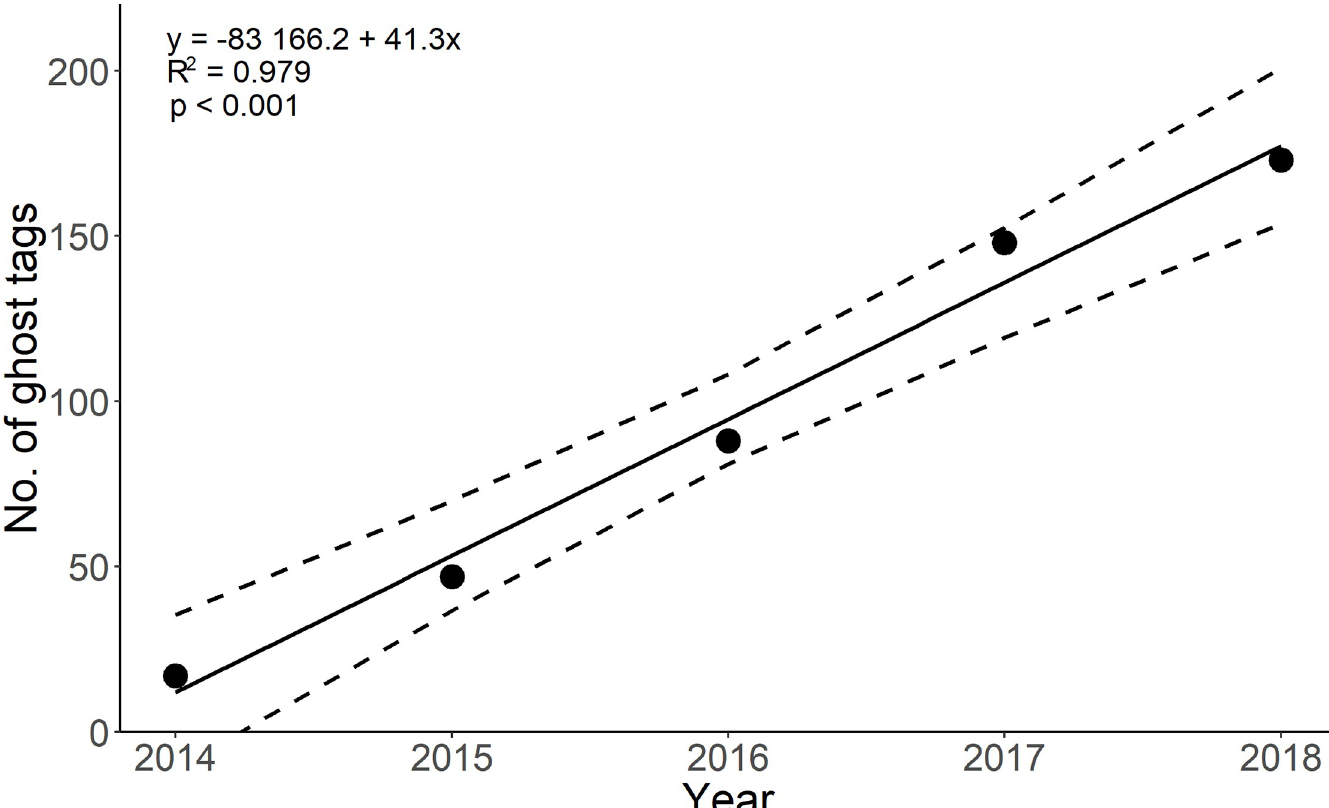
Fig 2. Accumulation of ghost tags on the spawning ground during the five years of the monitoring study. The points represent the cumulative number of PIT tags identified by portable backpack antenna. Dashed lines represent confidence intervals.